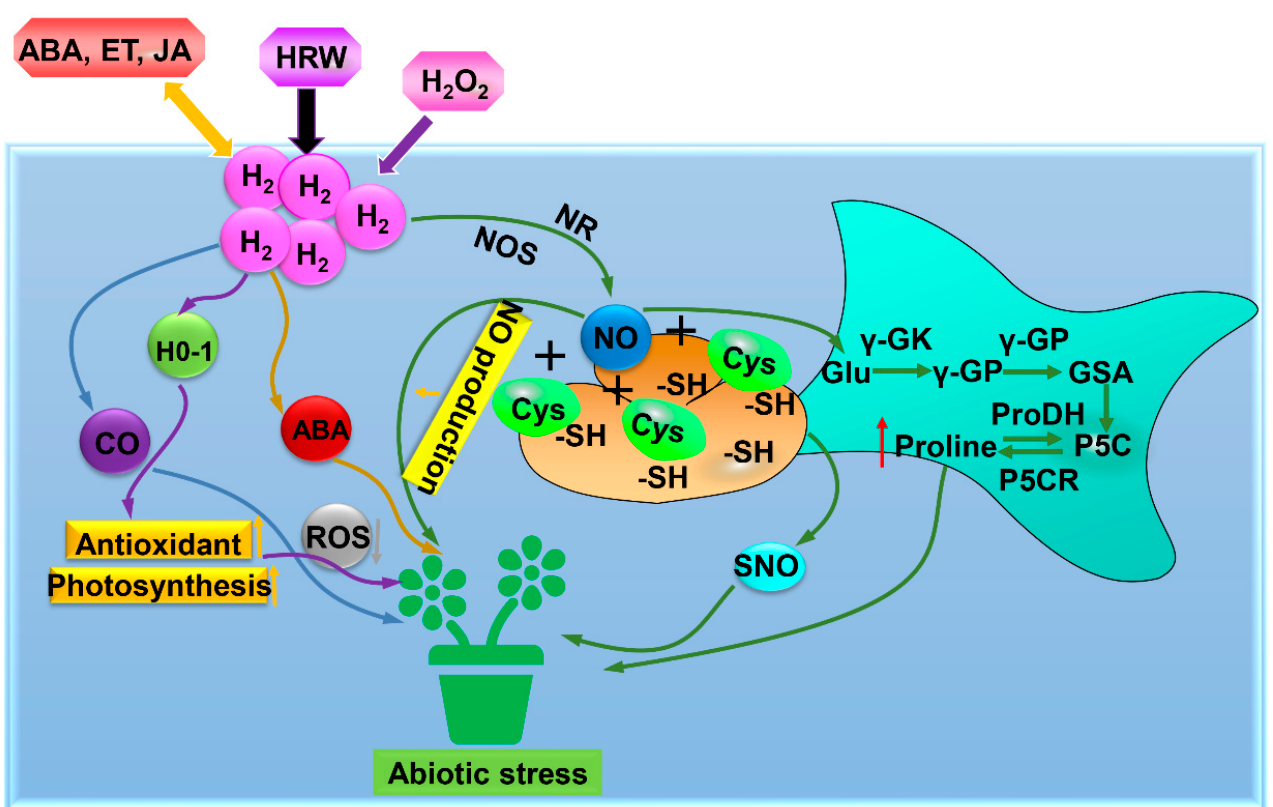
Figure 4. The mode of H 2 -mediated HO-1 signaling, NO, CO, and plant hormone action under abiotic stress. Under abiotic stress, H 2 could relieve abiotic stresses by S -nitrosylation, inducing proline synthesis and re-establishing redox balance. H 2 could also regulate the antioxidant system to relieve abiotic stresses in plants. Besides, H 2 responded to abiotic stresses by modulating ABA, ethylene, or jasmonate acid hormone signaling pathways. ABA, abscisic acid; ET, Ethylene; JA, Jasmonic acid; HRW, hydrogen-rich water; H 2 O 2 , Hydrogen peroxide; H 2 , Hydrogen gas; CO, carbon monoxide; HO-1, Heme oxygenase-1; ROS, Reactive oxygen species; NOS, nitric oxide synthase; NR, nitrate reductase; NO, nitric oxide; Cys, Cysteine; -SH, sulfhydryl group; SNO, S -nitrosylation; Glu, Glutamate; γ -GK, Glutamyl kinase; γ -GP, Glutamyl phosphate; GSA, Glutamyl semialdehyde; P5C, Pyrrolin-5-carboxylic acid; P5CR, Pyrroline 5-carboxylate reductase; Proline, Proline dehydrogenase.